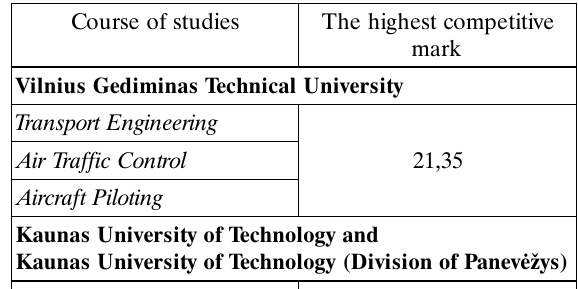
Table 4. The highest competitive marks (without any additional points) of the applicants to transport engineering courses of studies at various universities seidutsfoesruoC